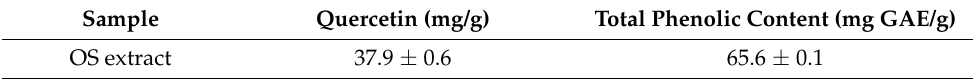
Table 2. Quercetin concentration and total phenolic content of A. cepa skin (OS) extracts. Sample Quercetin (mg/g) Total Phenolic Content (mg GAE/g) OS extract 37.9 ± 0.6 65.6 ± 0.1